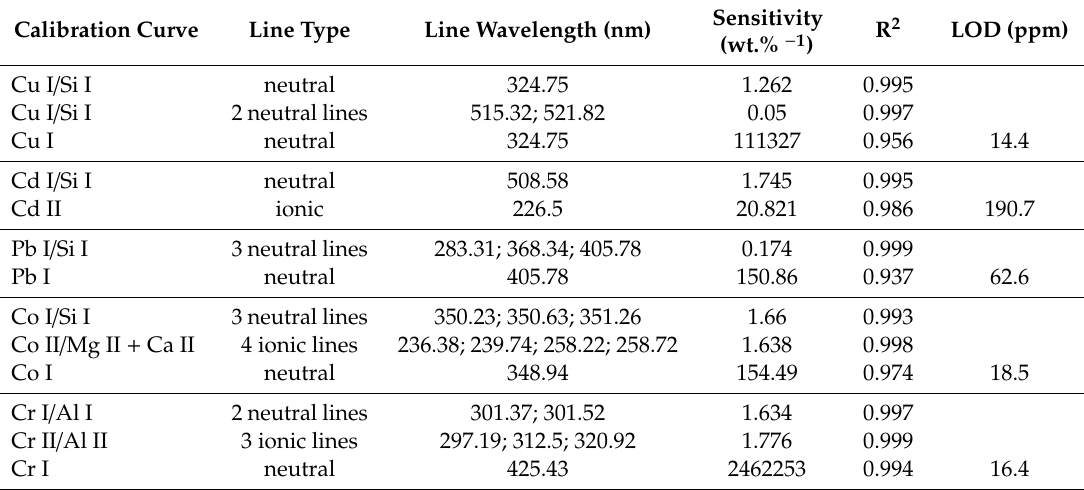
Table 4. Fitting parameters of the linear calibration